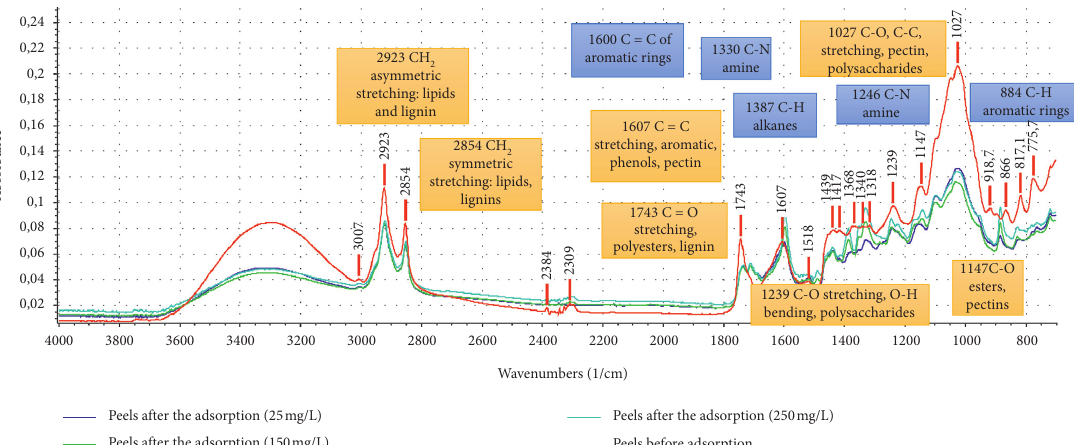
Figure 10: FTIR spectrum of nance peels before and after MB adsorption (pH 7). Blue tags correspond to functional groups of MB. Orange tags correspond to functional groups of the seeds.